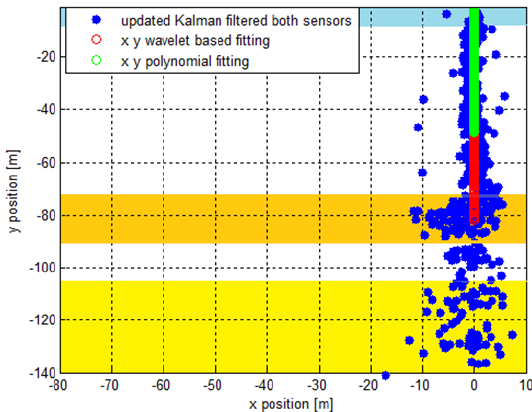
Figure 8. The results of the last experiment [16].